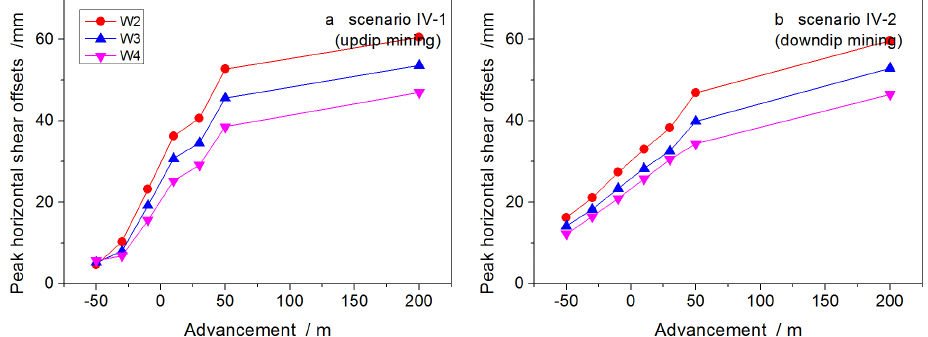
Figure 16. Dynamic evolution of peak horizontal shear offsets of well trajectories W2–W4 as the longwall panel advances ( a ) updip and ( b ) downdip. The abscissa represents the horizontal distance between the well and the working face after each stage of excavation. Negative magnitudes indicate that the advancing face is ahead of the well and positive magnitudes indicate that the face has passed the well.